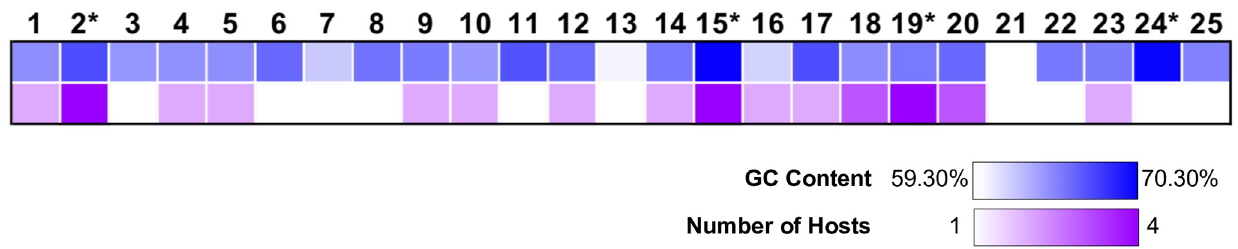
Fig 6. Evidence of horizontal gene transfer in the BlueFeather genome. The GC content for each gene in BlueFeather’s genome ranged from 59.30%- 70.30%, with an average of 64.30%. The number of unique isolation hosts that were represented in each pham ranged from 1–4. Genes with unexpectedly high values were considered to be the result of horizontal gene transfer. There were four genes with the most convincing evidence, indicated by � .